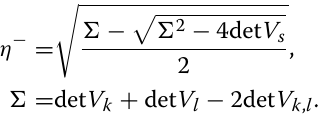
0.9 ω m , κ 2 0.5 ω 0.01 ω m , and J � 2 ω m , κ 1 γ m = − = = = = =